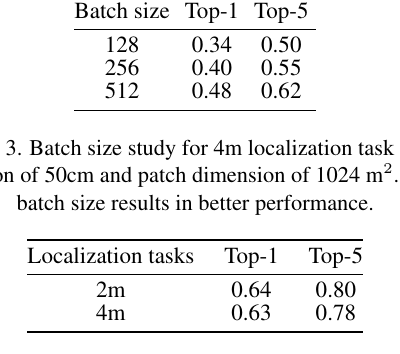
Table 4. Evaluation on the test set with ground sample distance of 50cm, patch dimension of 1024m 2 , and batch size of 512.